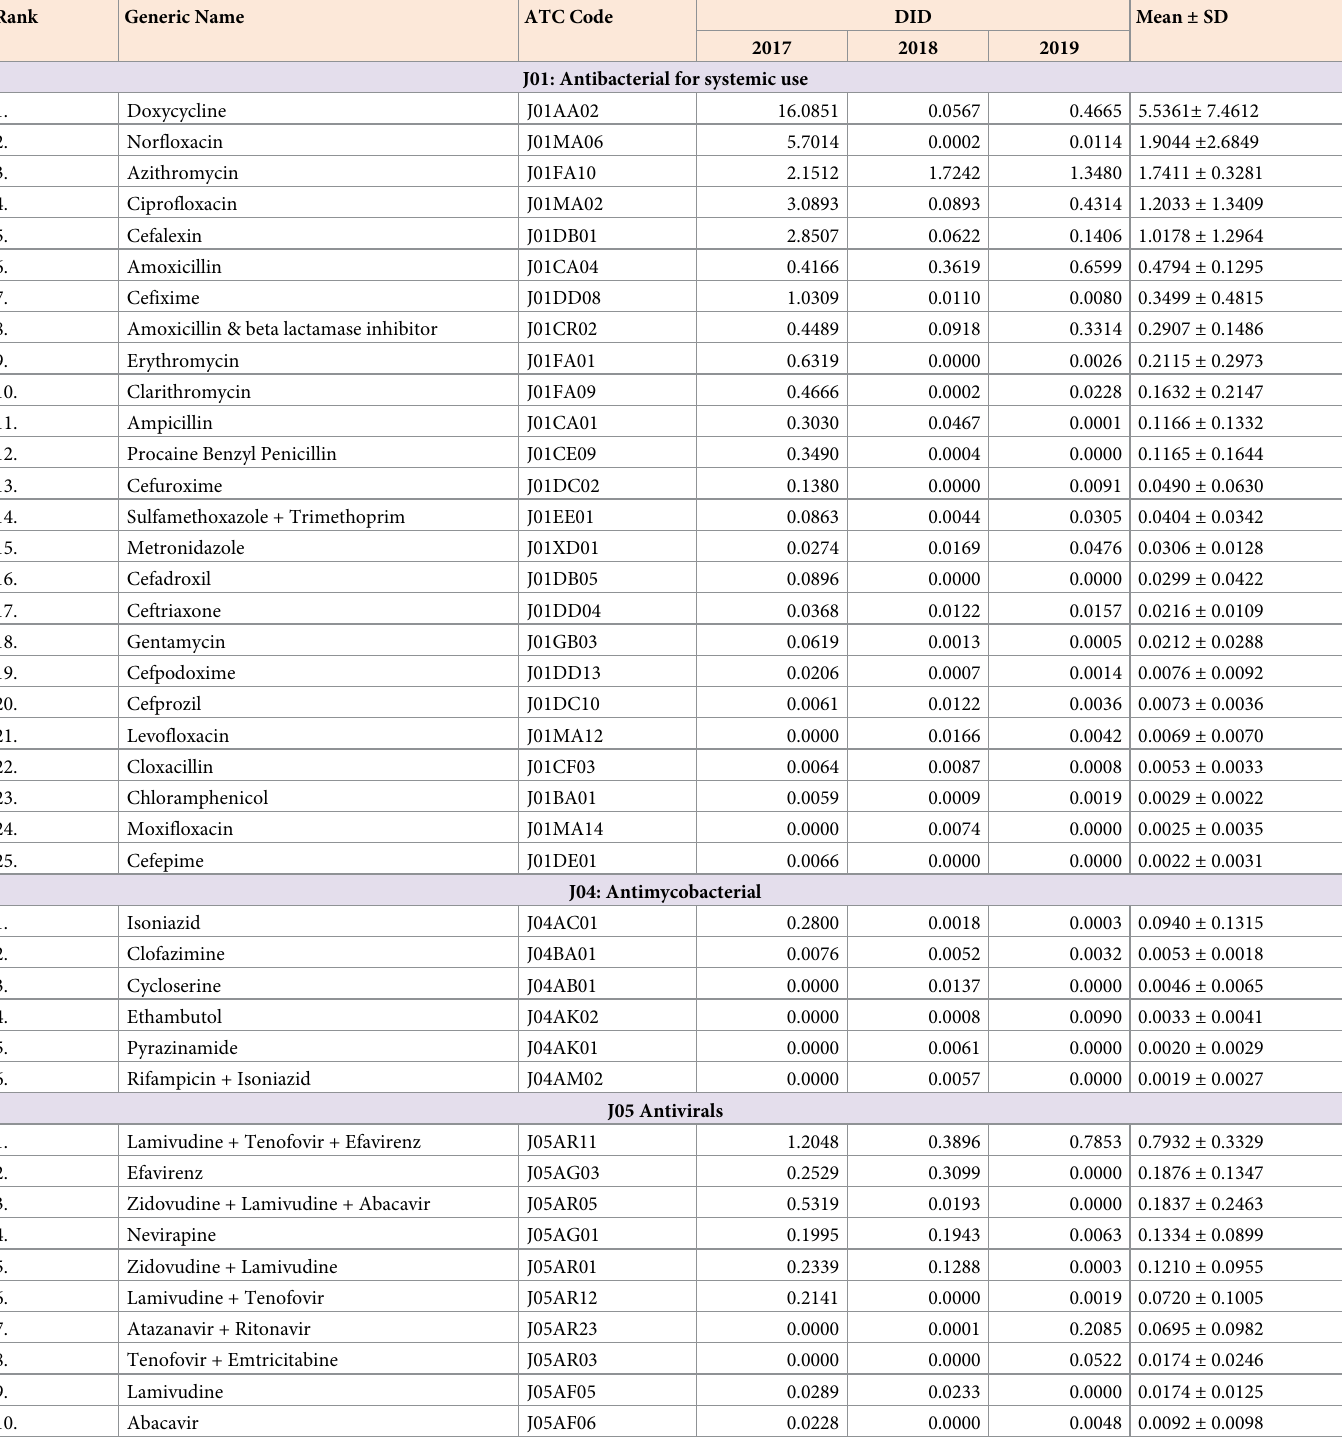
Table 5. Most commonly consumed antimicrobials by chemical substance group in Ethiopia between